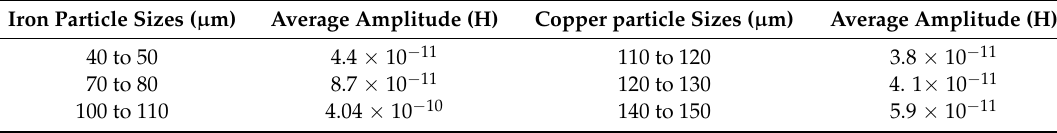
Table 2. The relationship between particle sizes and inductance amplitudes, the excitation frequency is 2 MHz and the number of coil turns is 20 turns.